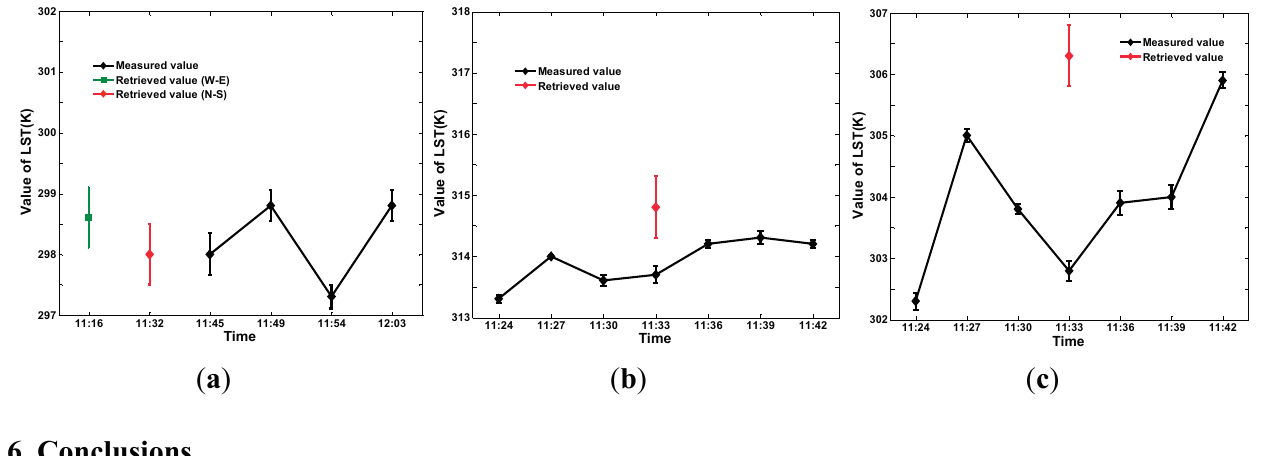
Figure 12. Validation results over three areas. ( a ) Retiro Park (water). ( b ) Soccer field (bare soil). ( c ) Football field